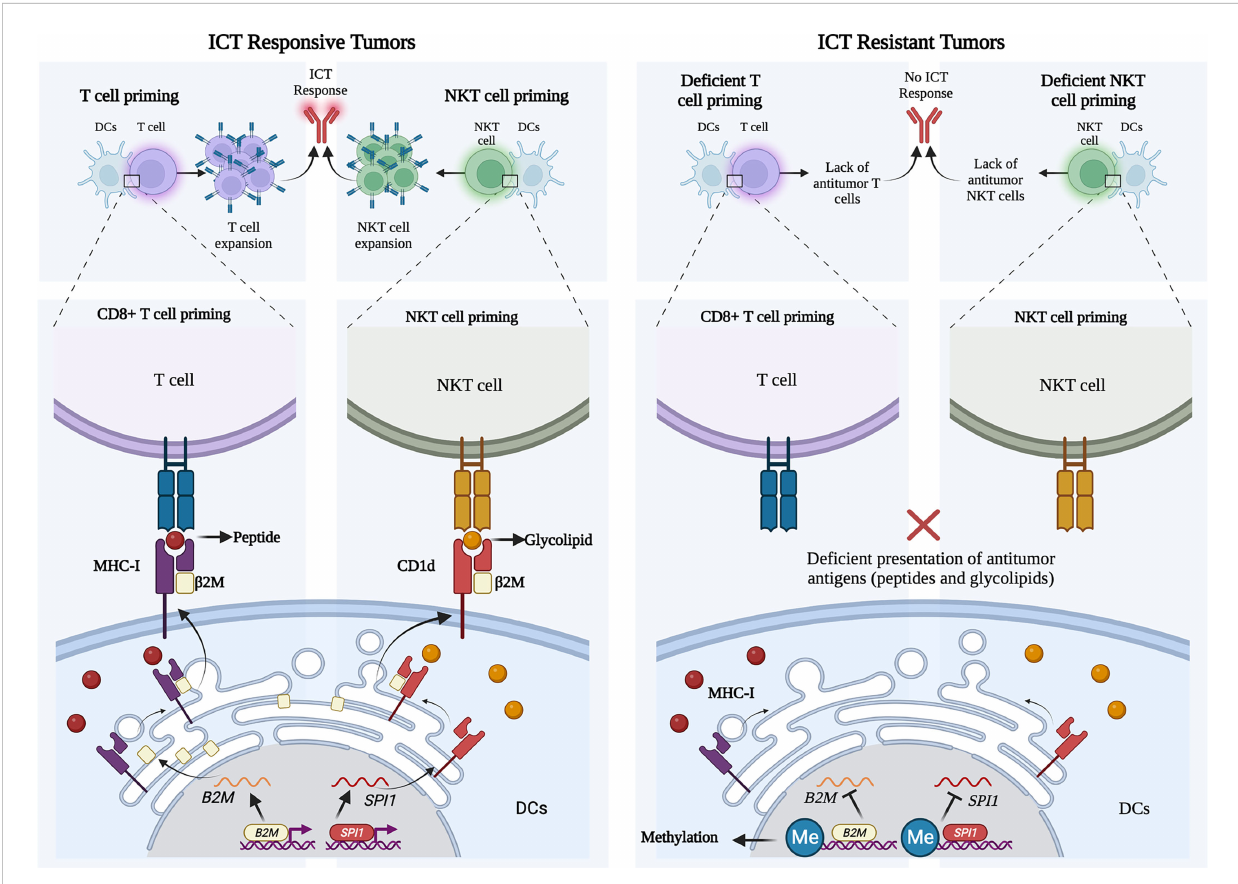
FIGURE 4 Schematic representation of B2M and CD1D expression pro fi le in ICT responsive and resistant melanoma tumors. Left panel: Successful priming of T cells and NKT cells by dendritic cells with the physiological engagement of b 2M with MHC and CD1d, respectively. Right panel: De fi cient priming of T cells and NKT cells by dendritic cells given to methylation of promoter regions of B2M and SPI1 , respectively, in patients not responding to